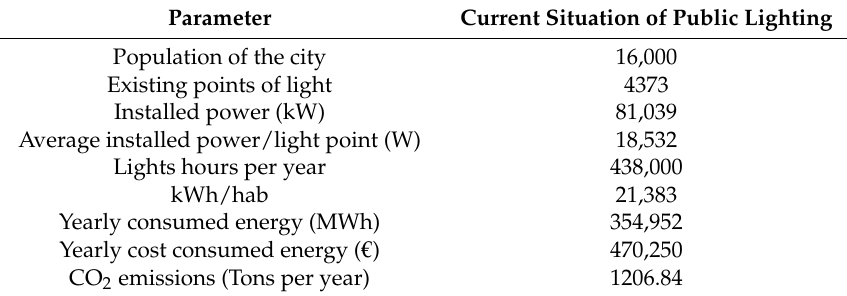
Table 1. Technical features of Baeza city public